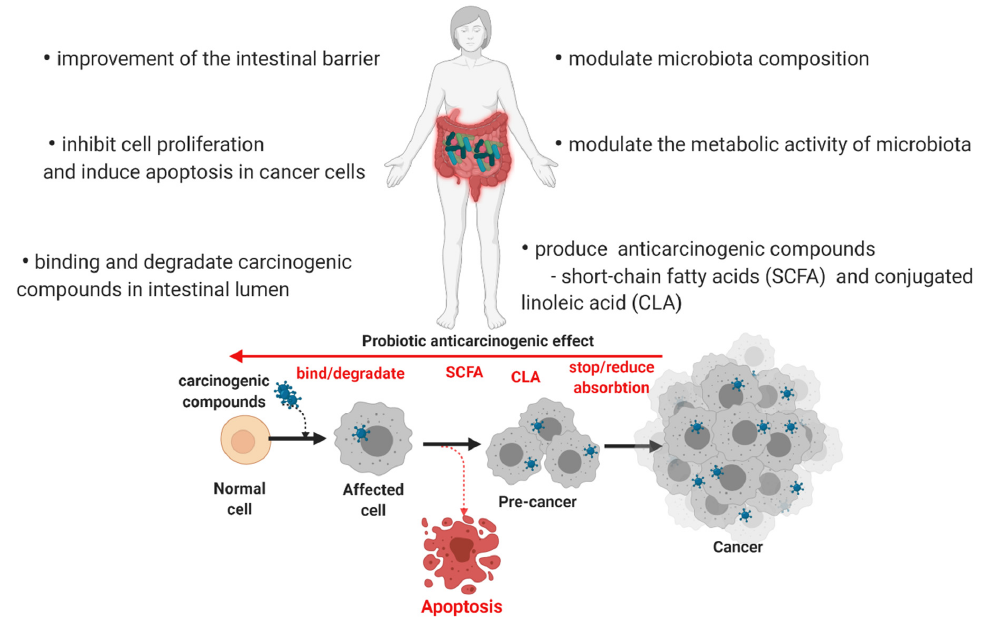
Figure 3. Anti-carcinogenic mechanisms of probiotics.